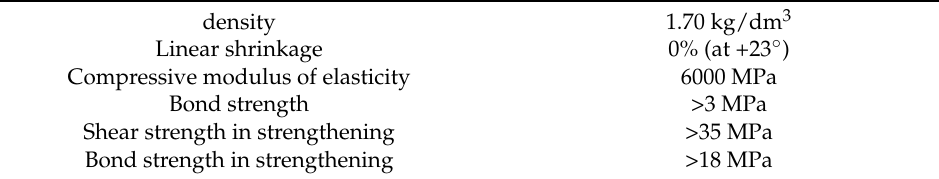
Table 6. Mechanical properties of epoxy